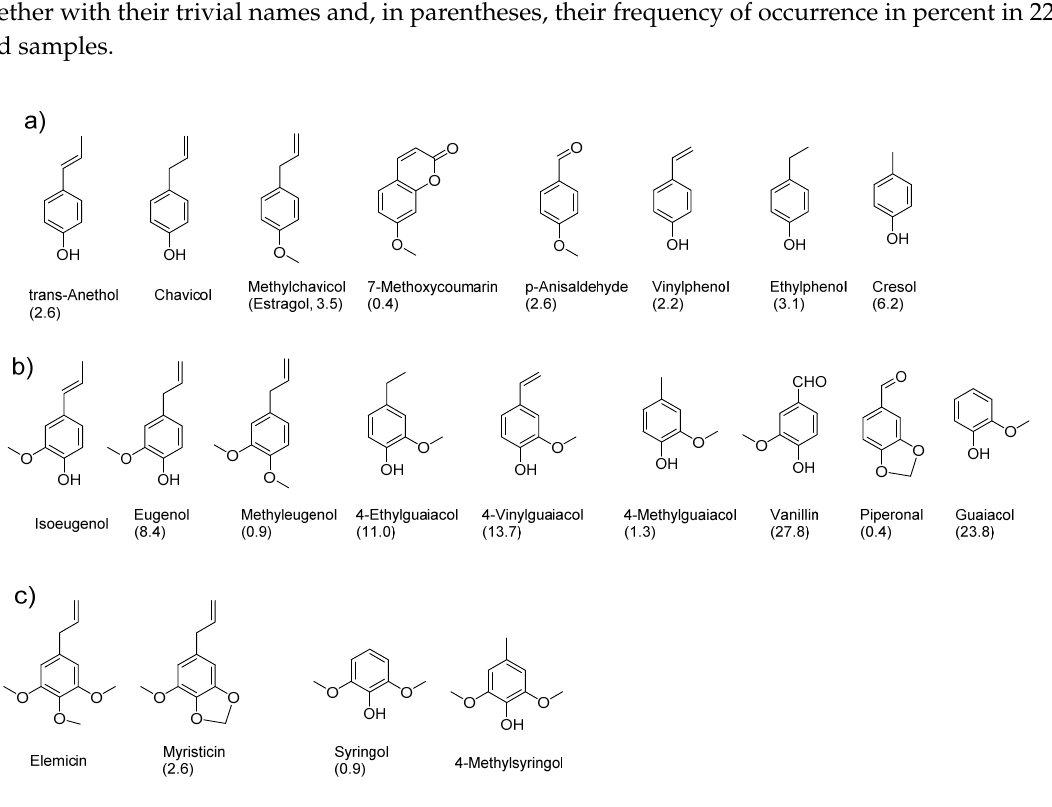
Figure 1. Structures of volatile odor-active phenols that were detected in 227 food samples [16].